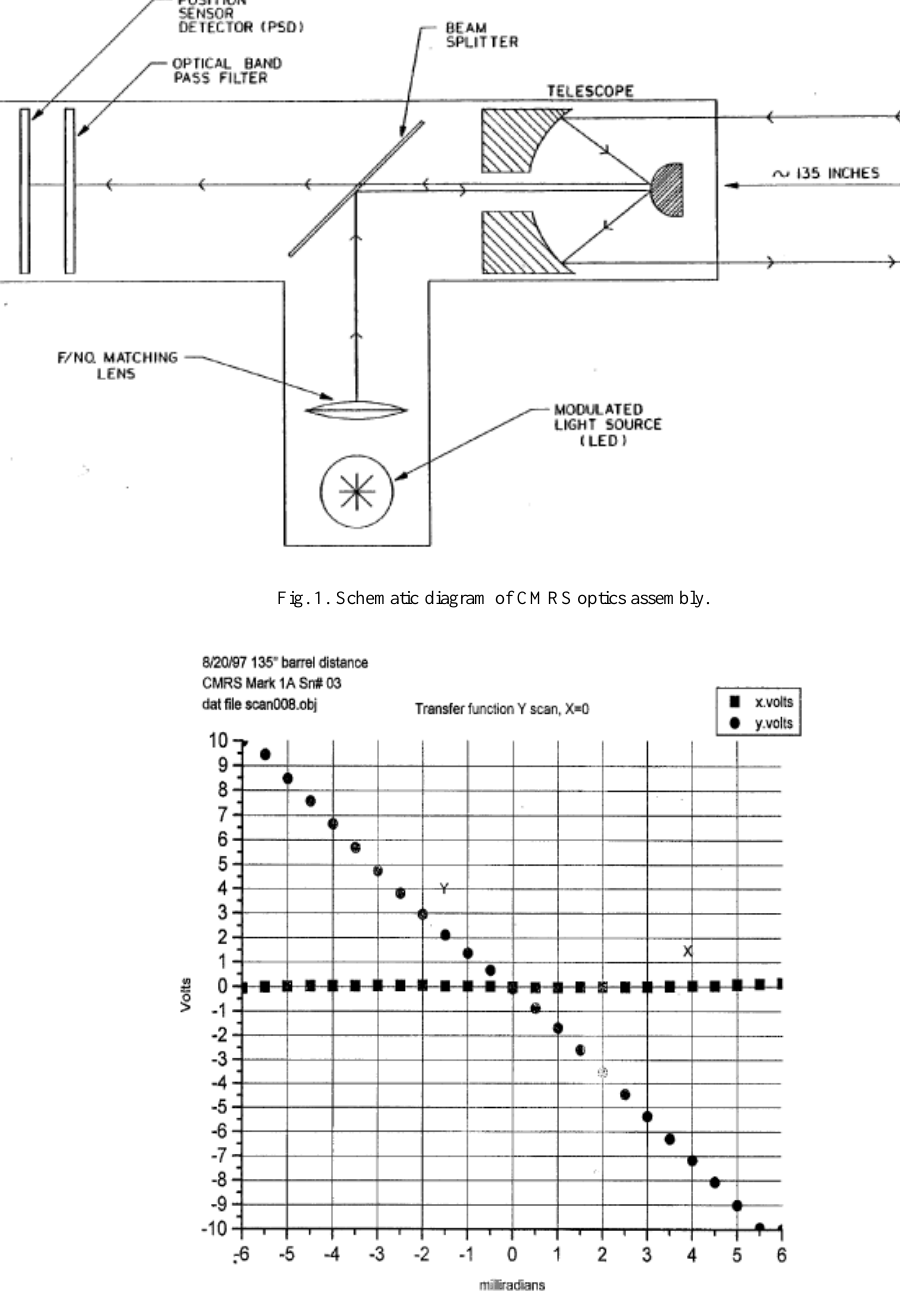
Fig. 2. Transfer function ‘Y’